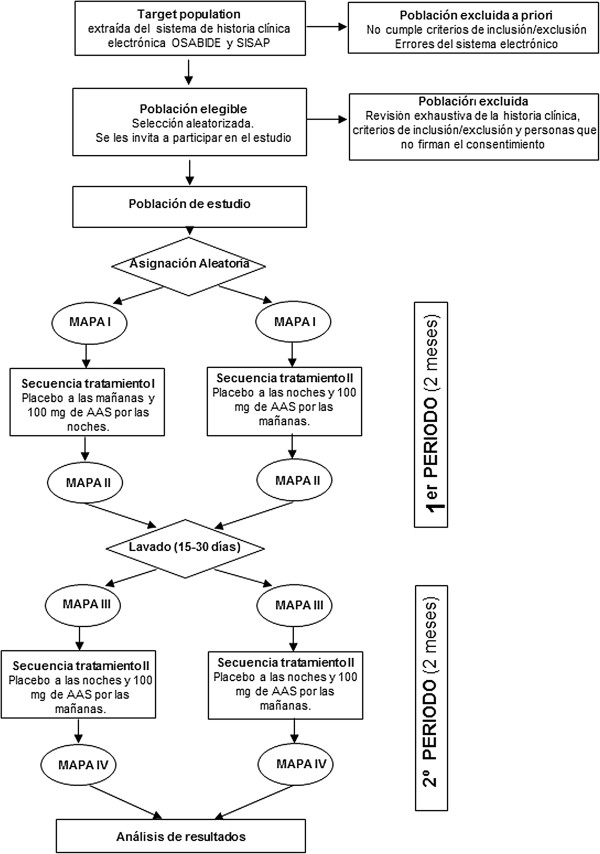
Flow of the study.